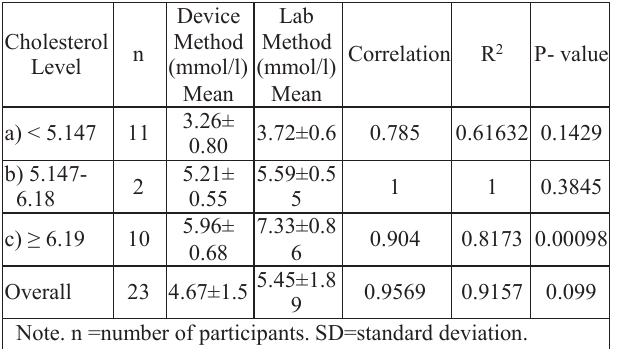
Table-4: Correlation between Device method and laboratory method according to Cholesterol level after optical window cleaning.